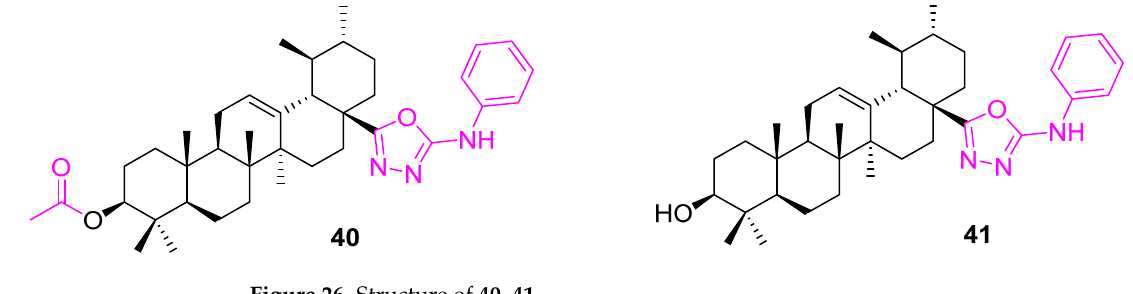
Figure 26. Structure of 40 , 41 .